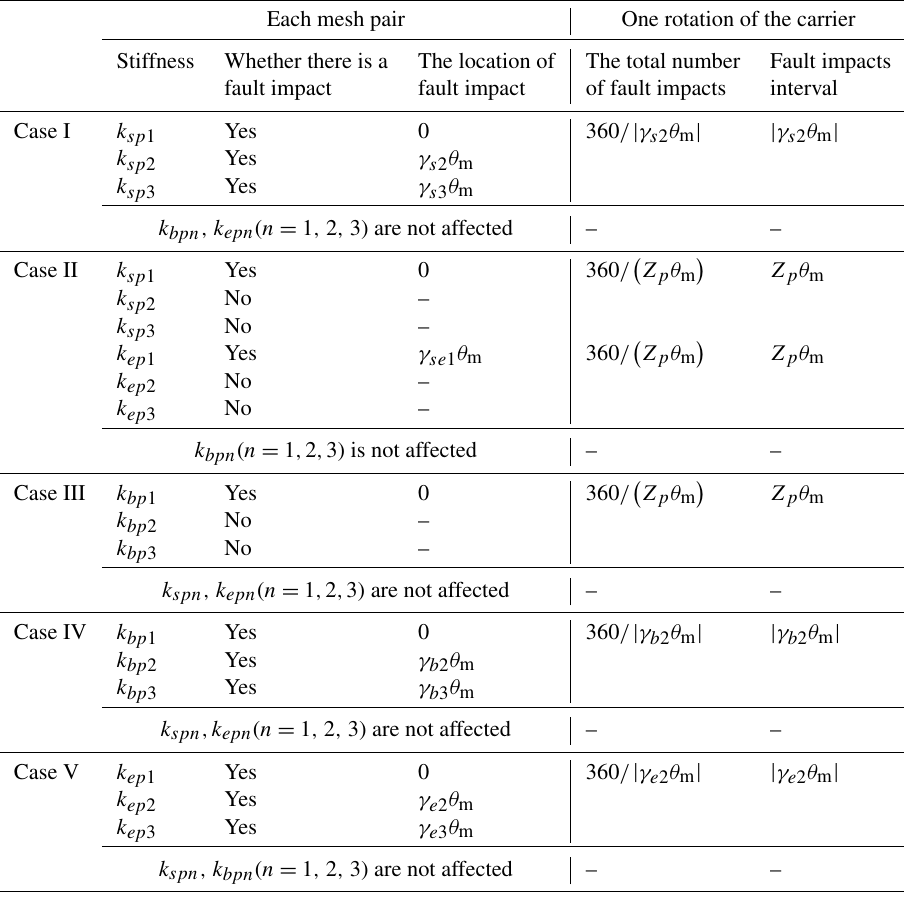
Table 2. Summary of meshing stiffness of each gear pair. Each mesh pair One rotation of the carrier Stiffness Whether there is a The location of The total number Fault impacts fault impact fault